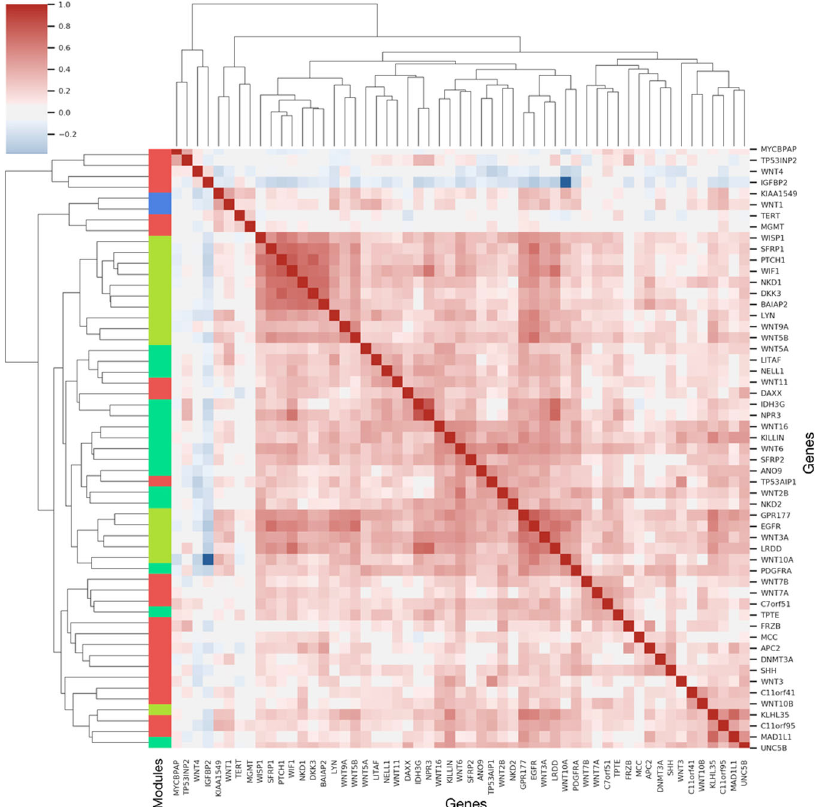
Fig. 5 MethylCapsNet-derived gene network. Clustermap of weighted bipartite network projection of select gene capsules ’ relationship to various CNS tumors using the MethylCapsNet modeling approach; rows and columns are genes, row colors denote modules (green, red, blue, and yellow) of genes found using Louvain modularity; values in matrix denote Pearson ’ s correlation between